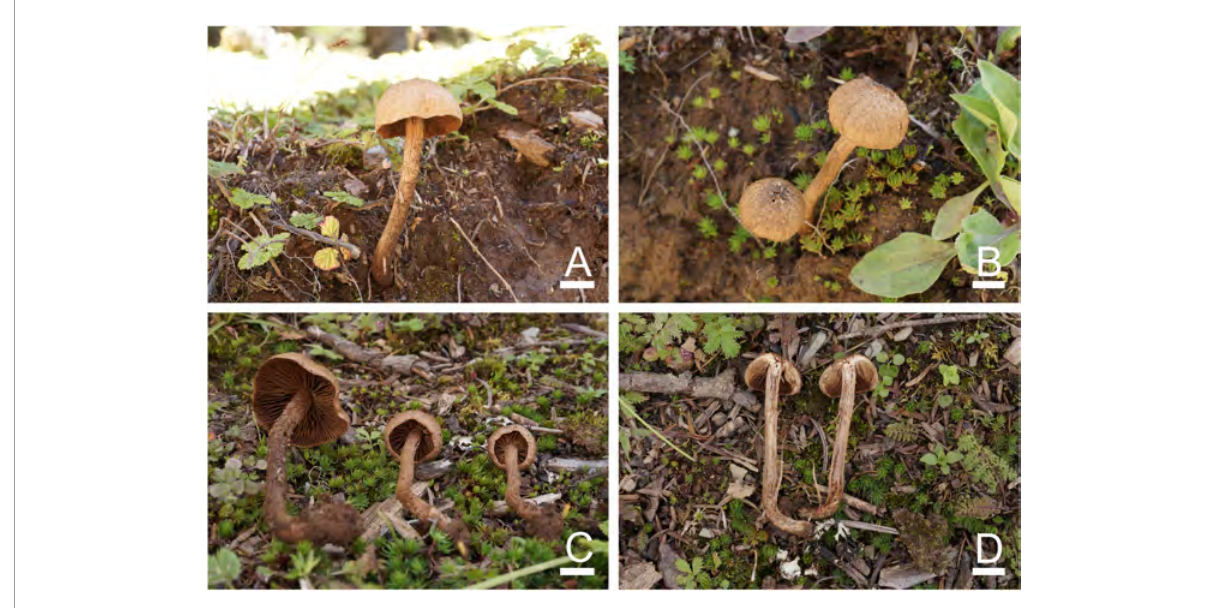
FIGURE6 Basidiomata of Inosperma longisporum . (A–D) MHHNU32337, holotype. Scale bars = 10 mm.